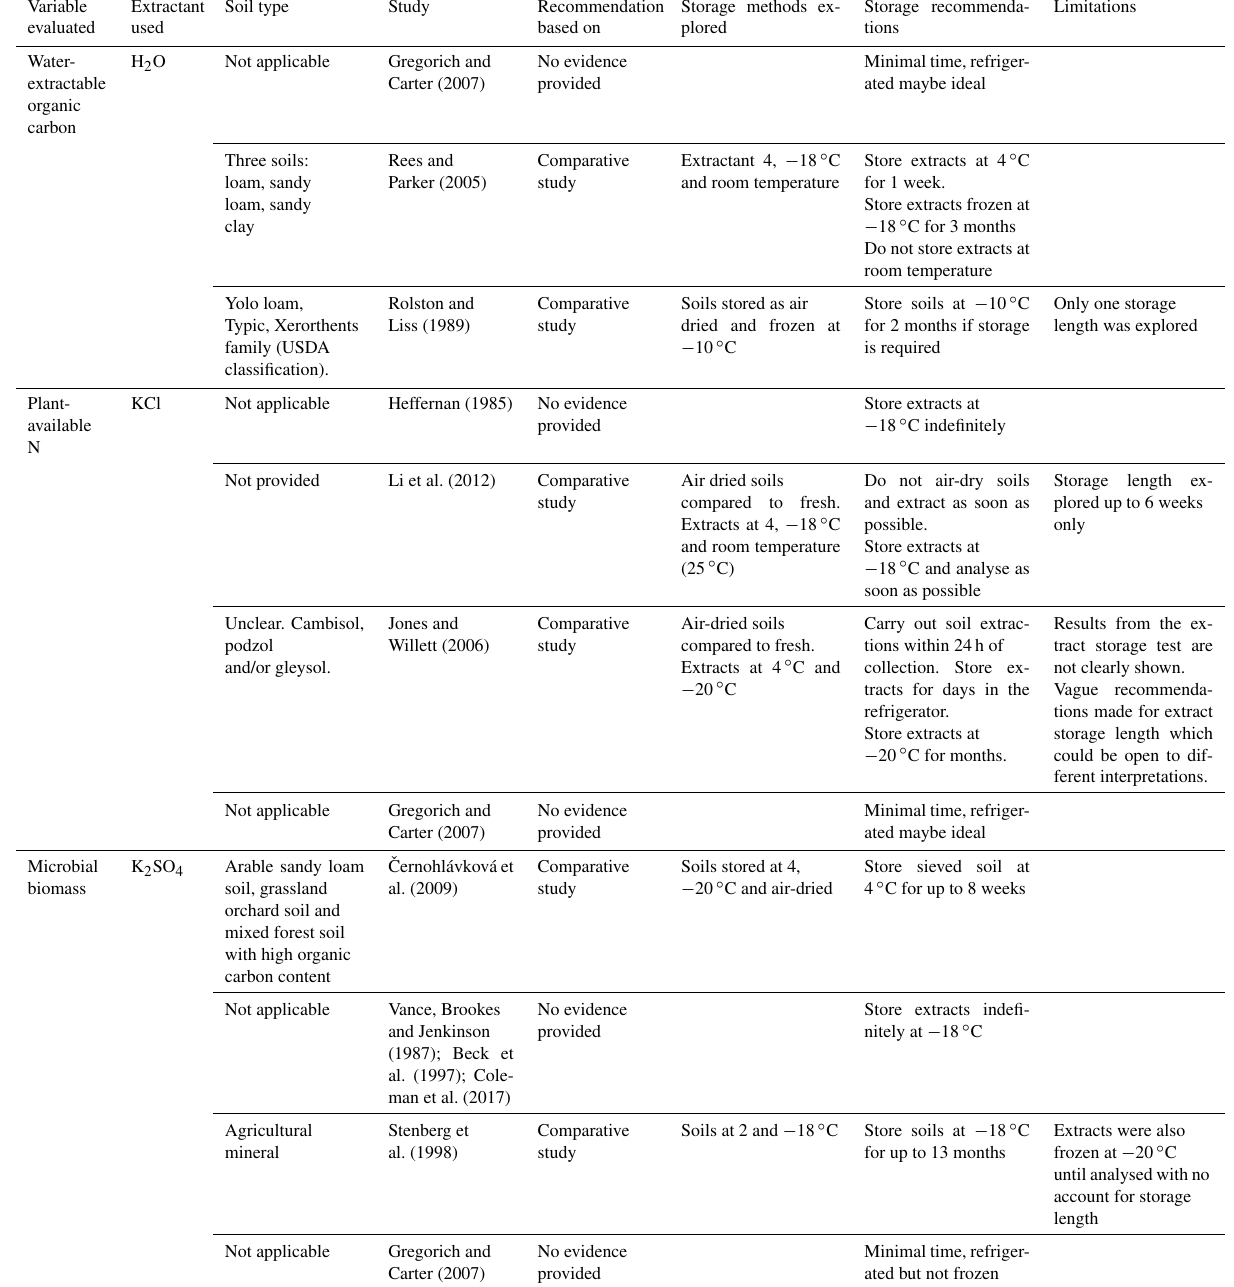
Table 1. Summary of different recommendations for storage of soil or extract samples to measure soil nutrients found in the literature. This summary is non-exhaustive. The term “not applicable” under soil type refers to studies that were not based on comparative studies and therefore were not carried out on a soil type. The term “not provided” refers to comparative studies that do not describe the soils explored in the